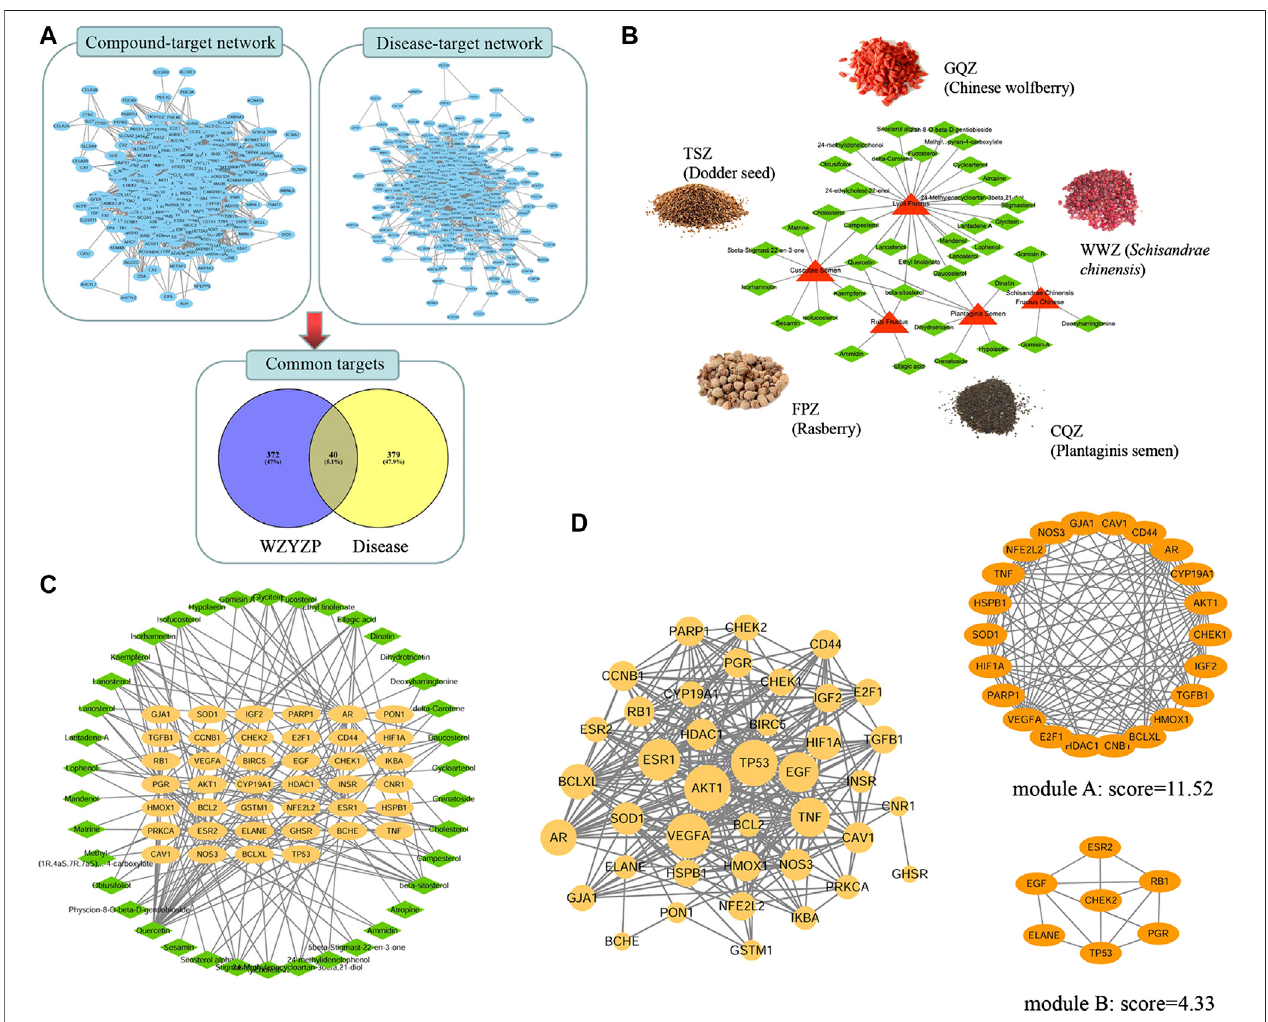
FIGURE 2 | Network Pharmacology analysis of the WZYZP for spermatogenesis disorder treatment. (A) Candidate target screening of the WZYZP for spermatogenesis disorder treatment. (B) Herb-compound network of the WZYZP. The red triangle represents different herbs in the WZYZP, and green diamond nodes represent active compounds. (C) The compound-target network of the WZYZP. The orange node represents the target, and green diamond nodes represent active compounds from differentherbs inthe WZYZP. (D) PPInetworkofthe targets. There are40nodesand 288edgesin thePPInetwork,sometargets (AKT1,TP 53, VEGFA, ESR1, EGF, and TNF) were identi fi ed with high node degrees. Two modules were screened from the PPI network, and the module scores are 11.52 and 4.33, respectively.